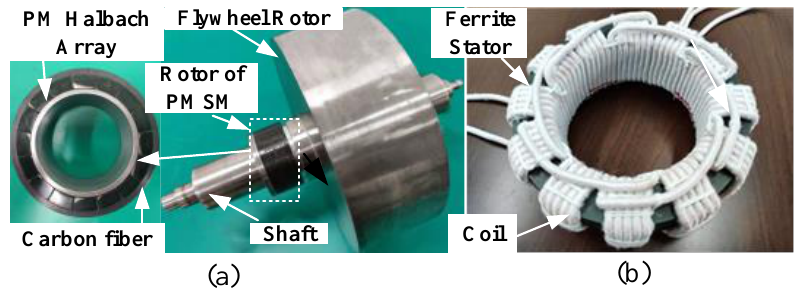
Figure 13. The PMSM of the FESS. ( a ) The rotor. ( b ) The